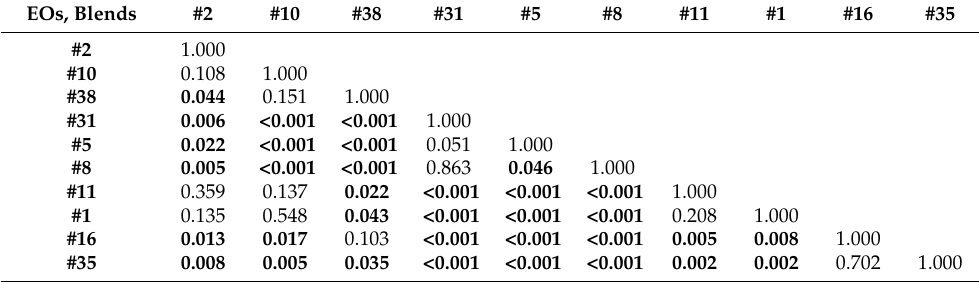
Figure 2. ( a ) Inhibitory Concentration (IC 50 in µ g mL − 1 ; upper panel) and ( b ) Minimum Bactericidal Concentration (MBC in µ g mL − 1 ; lower panel) for the top-10 most effective blends of essential oils against the fish pathogen Aeromonas veronii bv. sobria . The exact composition of the seven essential oils in each blend is shown in Table S2. Table 3. Pairwise comparison ( t -test) with established statistical differences (bold) among the top-10 blends of essential oils (EOs) presenting the highest bactericidal activity against the fish pathogen Aeromonas veronii bv. sobria . For the composition of the tested EOs, see Table S1 (Supplementary